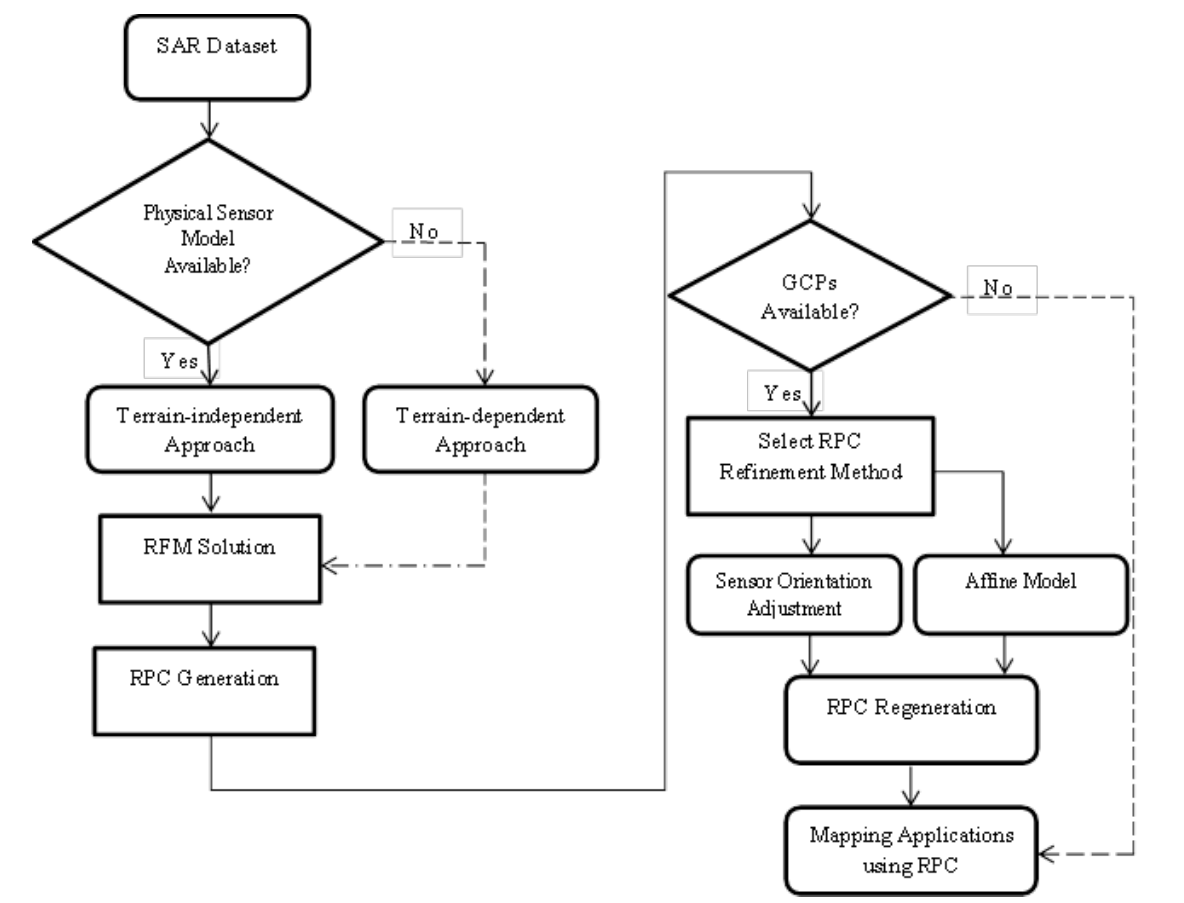
Figure 1. General workflow of developing a rational functional model [11]. SAR: synthetic aperture radar, RFM: rational function model, GCP: ground control point, RPC: rational polynomial